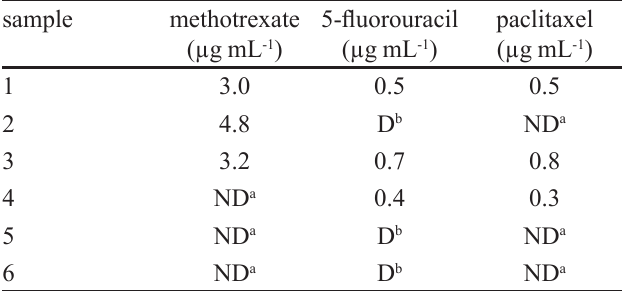
TABLE V - Antineoplastic drugs analyzed in glove samples using the proposed method